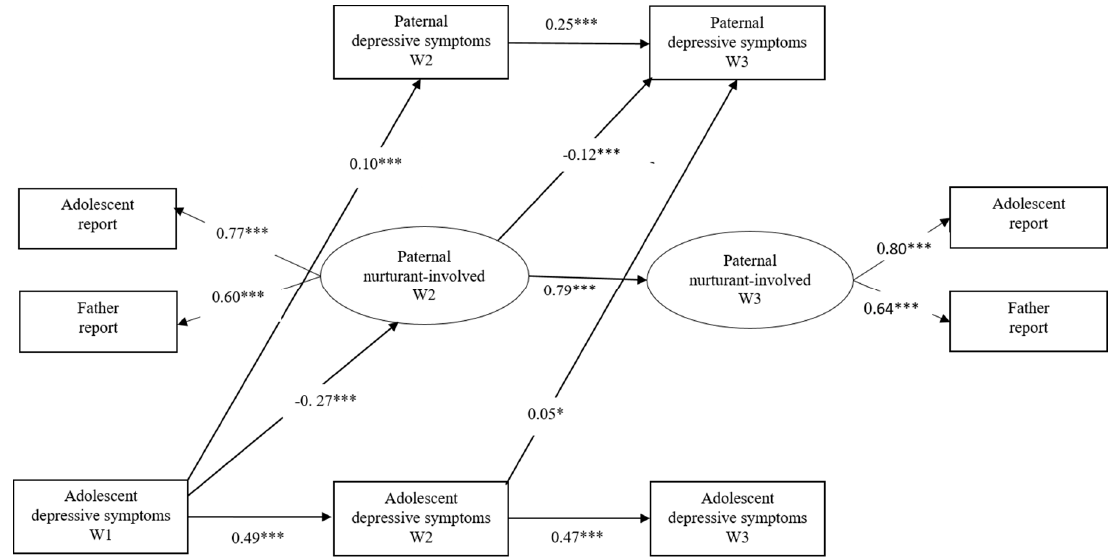
Figure 4. Transactional effects between adolescents’ depressive symptoms, paternal nurturant–involved parenting and paternal depressive symptoms. Paternal nurturant–involved = paternal nurturant–involved parenting. * p < 0.05, *** p < 0.001.